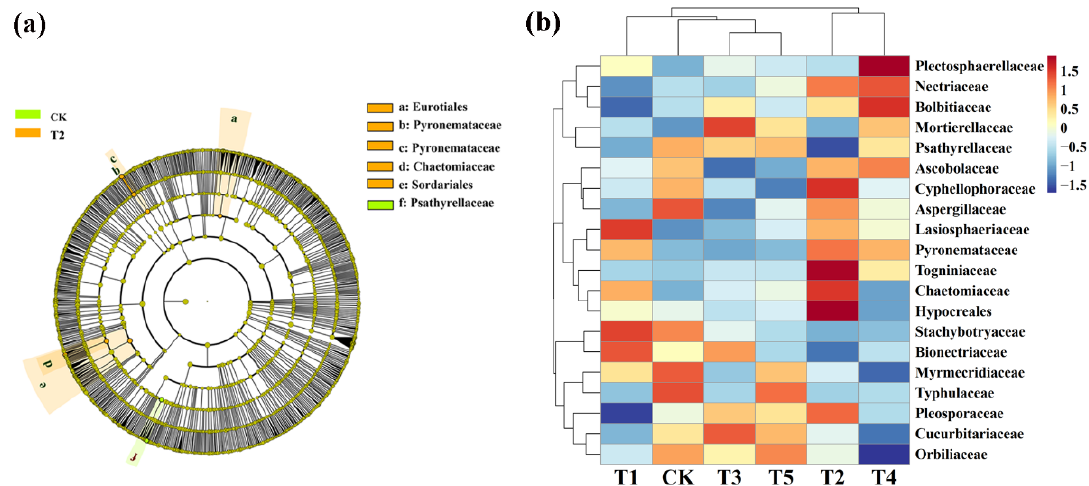
Figure 7. Linear discriminant analysis (LDA) effect size (LeFse) of the fungal taxa ( a ), which identified the most differentially abundant taxa among the different microbial fertilizer treatments. Only taxa with LDA values greater than 4 ( p < 0.05) are shown. Hierarchical clustering analysis and heat mat at the family level ( b ). The tree plot represents a clustering analysis of the top 20 fungi at the family level according to their Person correlation coefficient matrix and relative abundance; the upper tree plot represents a clustering analysis of soil samples according to the Euclidean distance of data. T1, T2, T3, T4, T5, and CK represent the treatment of Tuzangjin microbial fertilizer (TMF), carbonergic microbial agent (CMA), seaweed microbial fertilizer (SMF), sheep manure (SM), chemical compound fertilizer (CCF), and the control (CK),